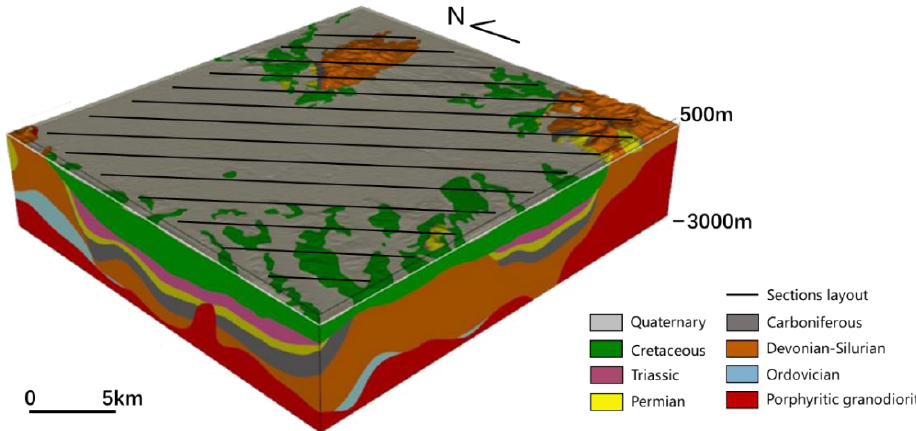
Figure 5. 3D model of the Xuancheng–Magushan Area. (Modified from Ye. [43] and Hu et al.